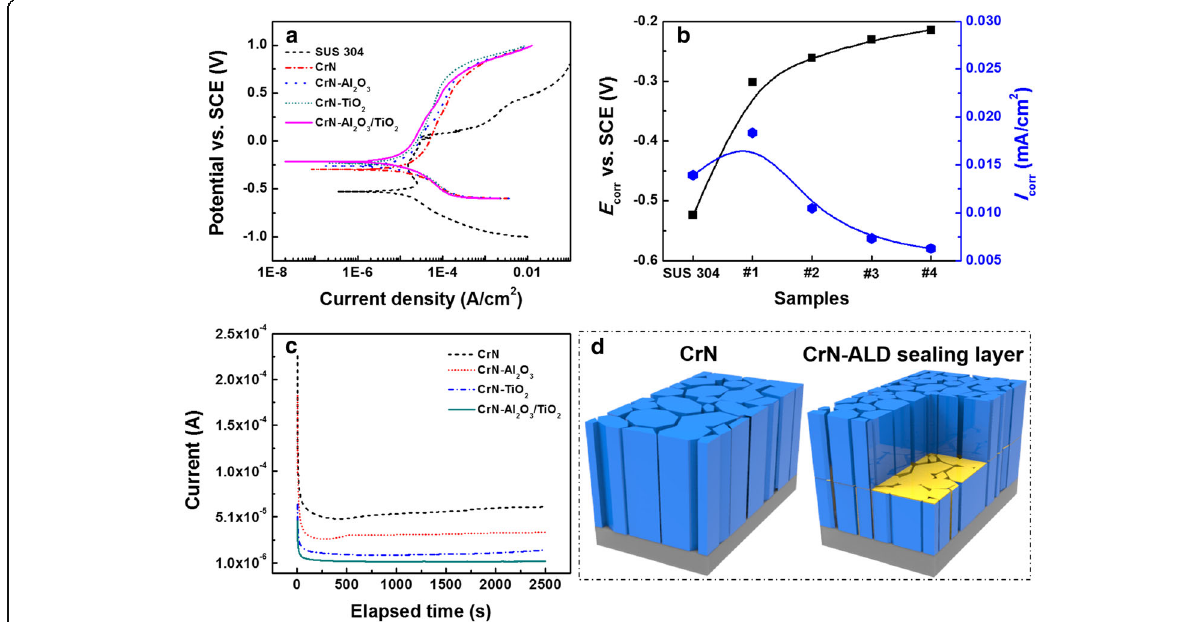
Fig. 5 Potentiodynamic and potentiostatic curves of the SUS304 substrate, SUS304 substrate coated with CrN, CrN-Al 2 O 3 , CrN-TiO 2 and CrN- Al 2 O 3 /TiO 2 in 3.5 wt. % NaCl solution: a potentiodynamic curves. b calculation value of the corrosion potential and corrosion current density. c potentiostatic curves. d schematic illustration of corrosion behavior of the pure CrN coating and hybrid